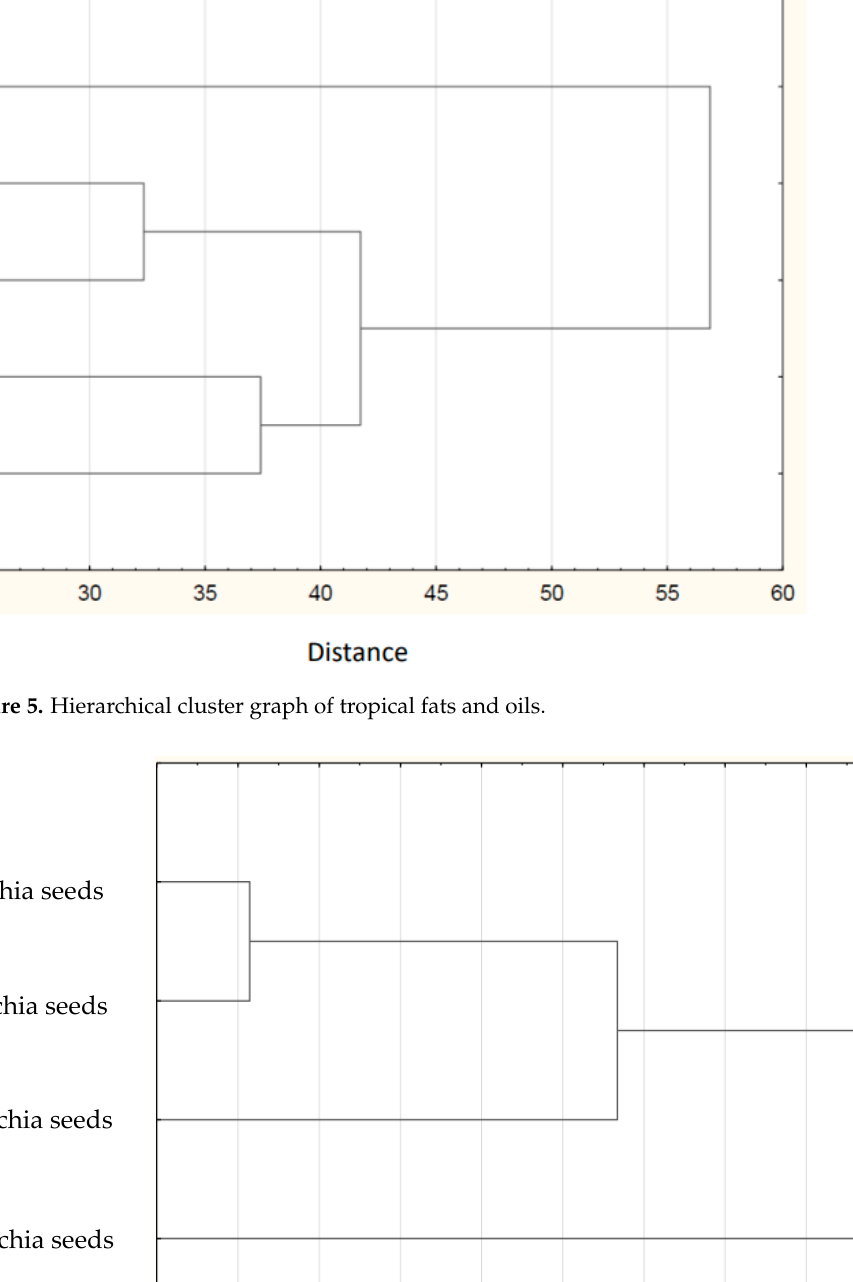
Figure 6. Hierarchical cluster graph of chia seed (extracted, processed and un-processed).